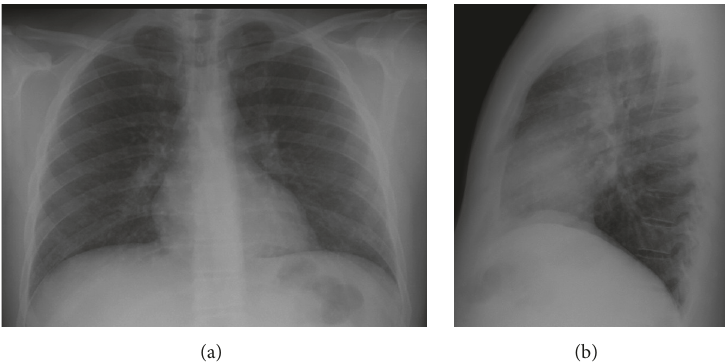
Figure 1: Posteroanterior (a) and lateral (b) chest X-rays. The chest radiography showed a diffuse nodular pulmonary pattern in both